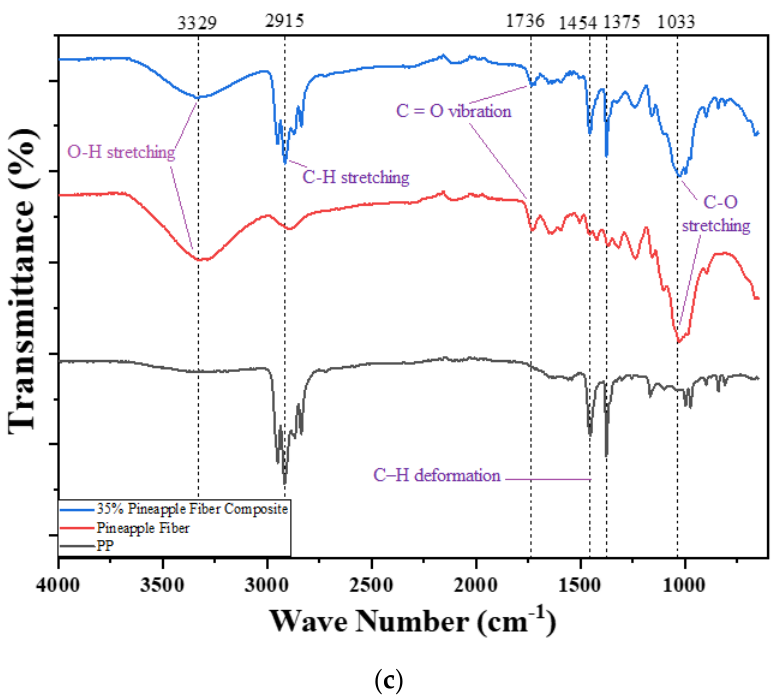
Figure 4. FTIR spectra of the PP, fibers and composites reinforced with 35 wt.% ( a ) jute, ( b ) kenaf, and ( c ) PALF.